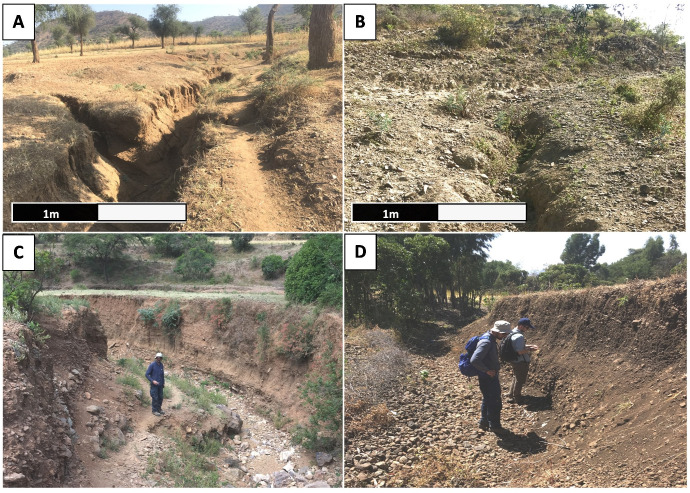
A. Gully along pathway in the Rama sample unit (1), B. Initial gully head development perpendicular to a pathway in the Rama sample unit (1), C. Gully in the Yeha sample unit (2) with a small pathway descending into it, D. Gully in the Daragà sample unit (3).